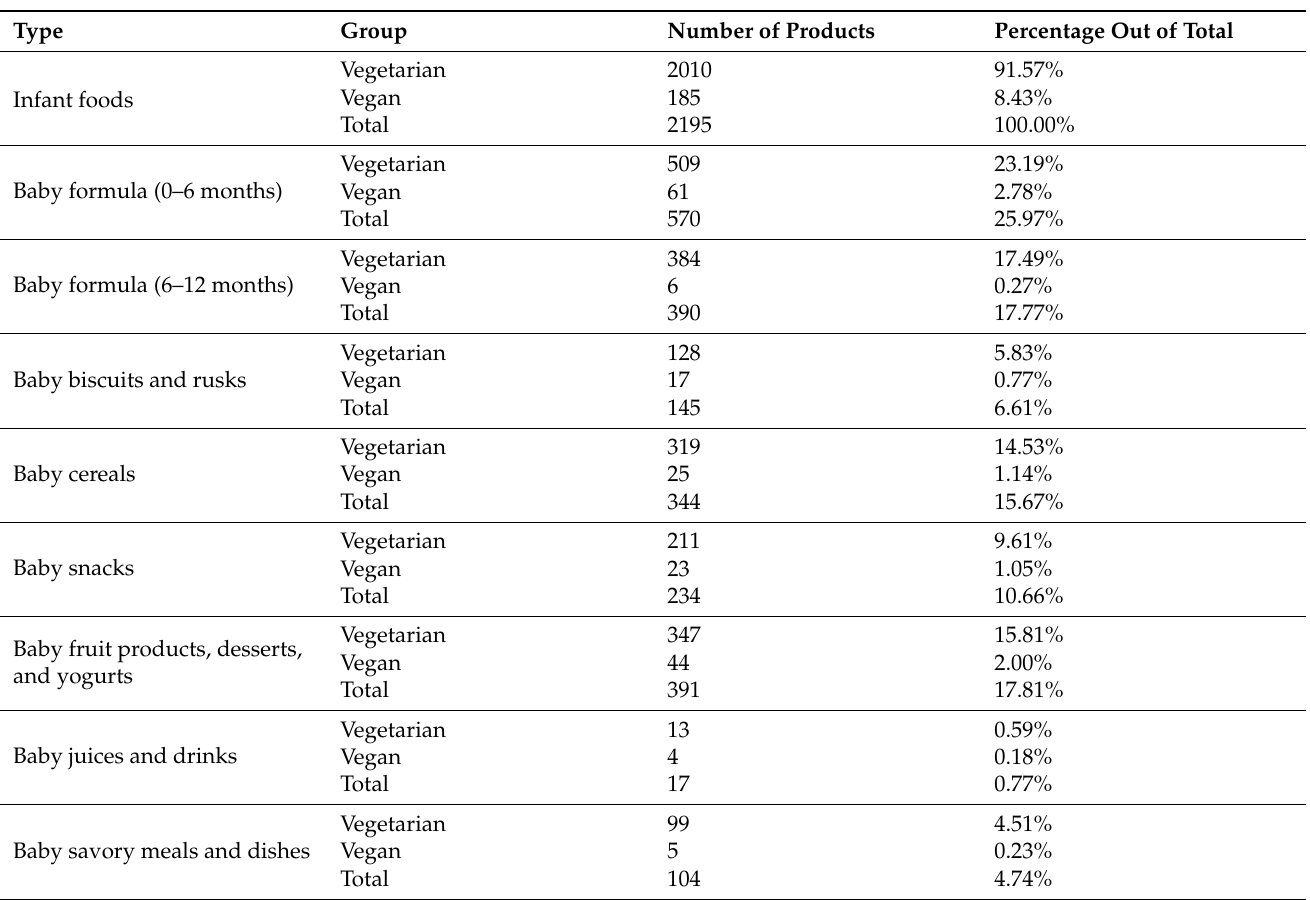
Table 1. Distribution of infant foods across product